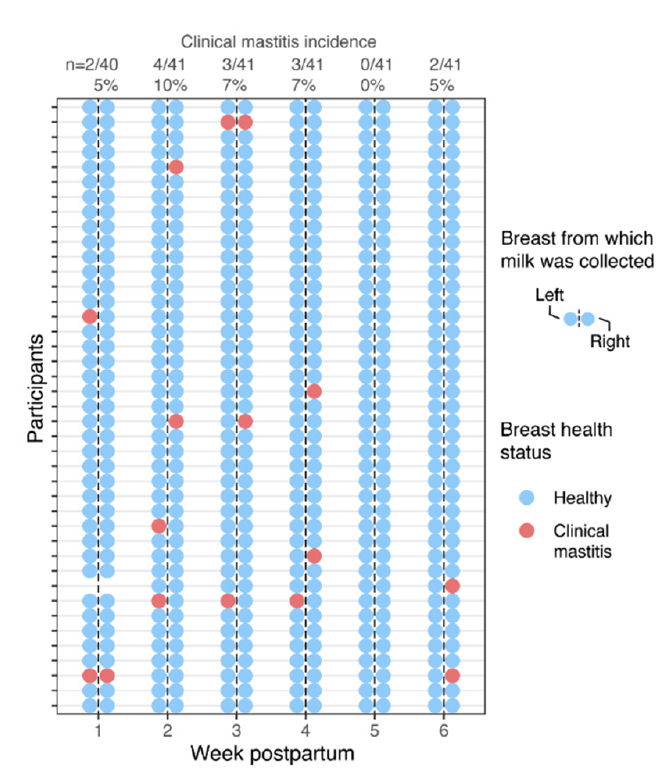
Figure 1. Overview of milk samples collected and incidence of clinical mastitis. A total of 41 participants were enrolled and provided weekly bilateral milk samples over the first 6 weeks postpartum. Incidence of mastitis by breast is notated by the red circles, and number and proportion of participants with clinical mastitis during each week are given at the